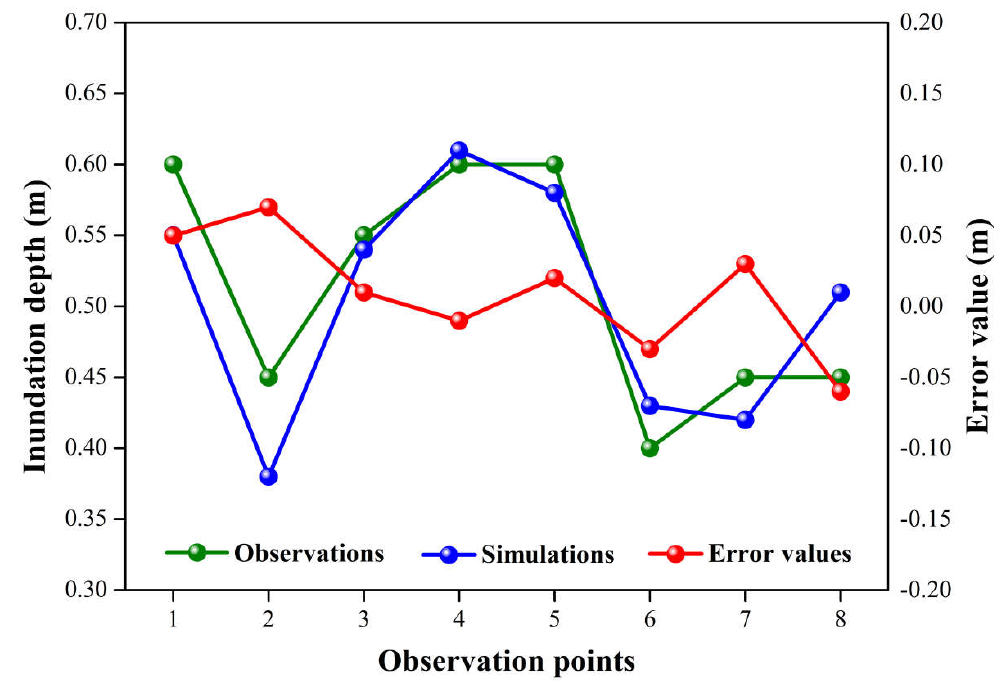
Figure A1. Calibration of the PCSWMM model.